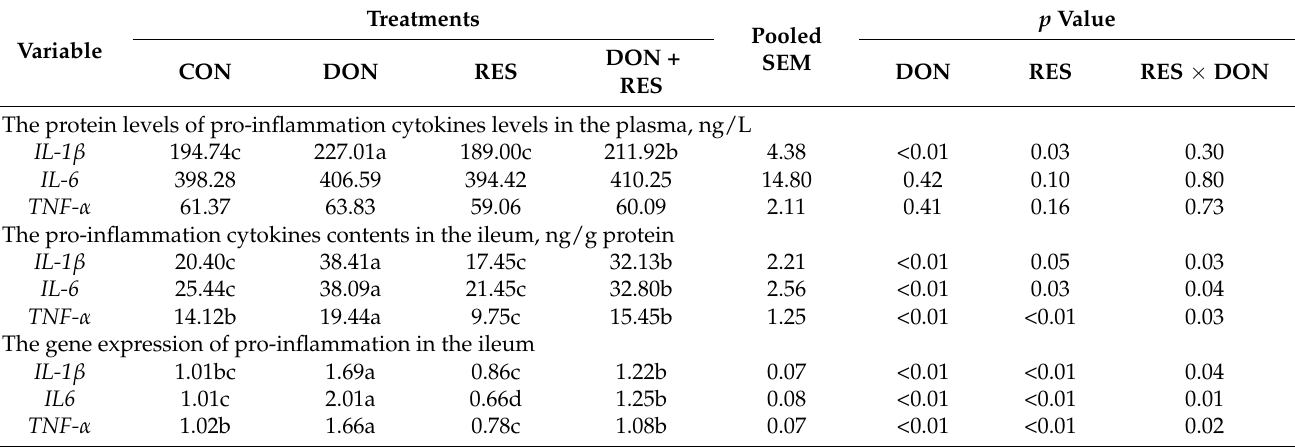
Table 5. Effects of resveratrol on the expression of cytokine in the plasma and ileal mucosa of weaned piglets challenged with deoxynivalenol 1